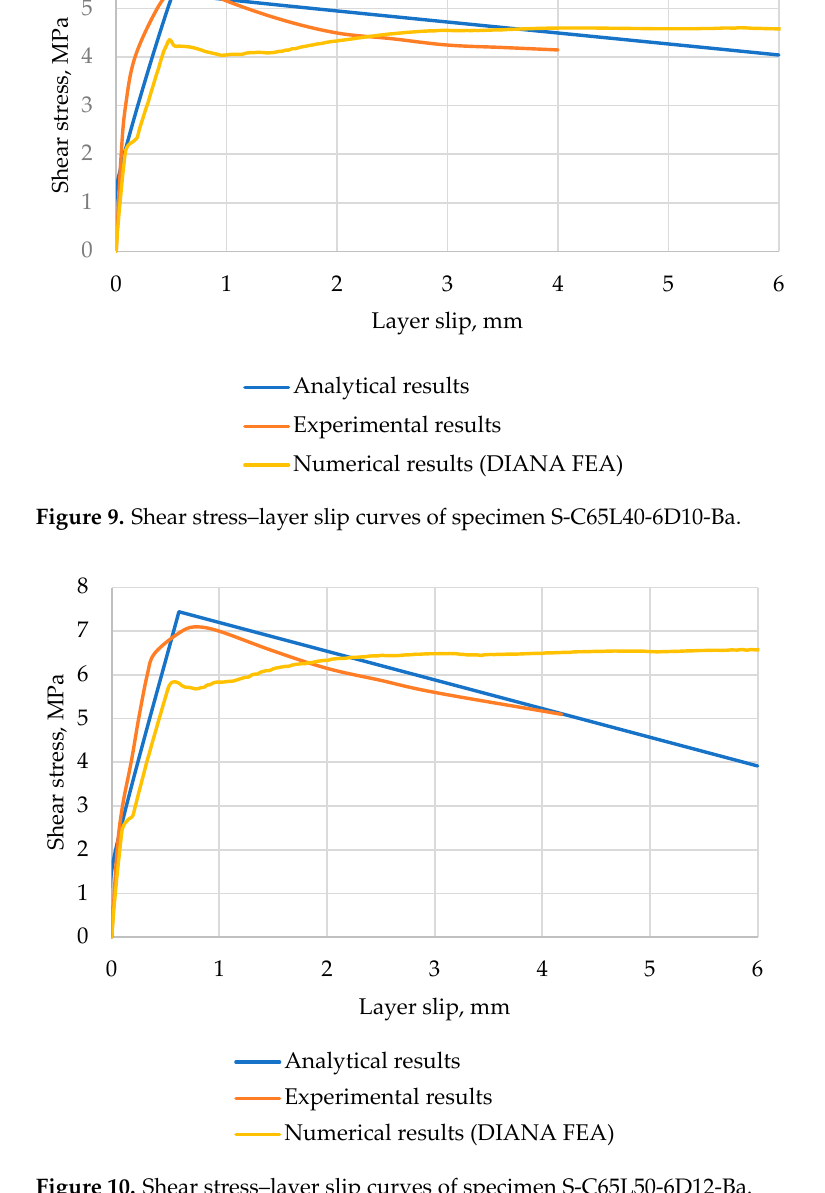
Figure 10. Shear stress–layer slip curves of specimen S-C65L50-6D12-Ba.